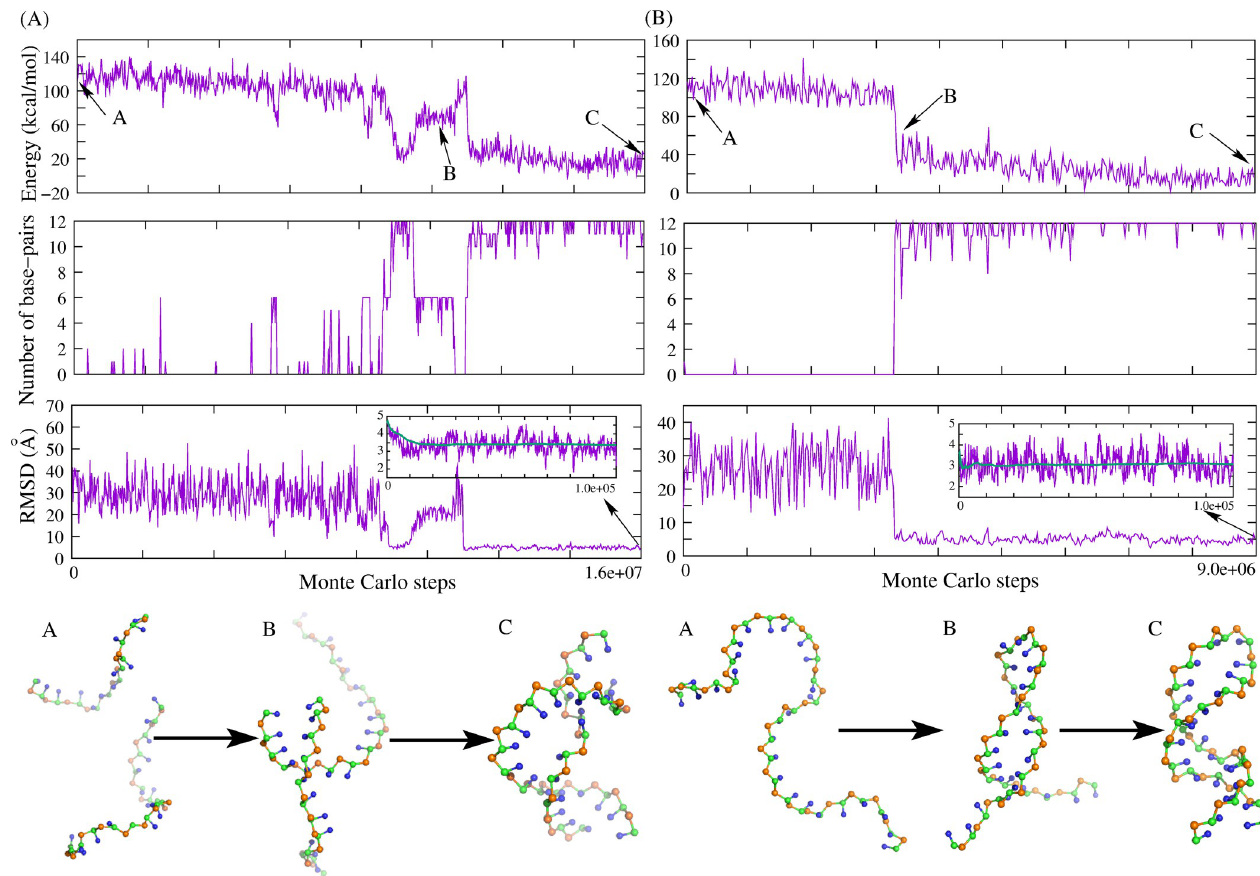
Fig 2. 3D structure prediction for the paradigm dsDNA/ssDNA in the present model. (A,B) The time-evolution of system energy, number of base-pairs, RMSD from native structure, and typical 3D conformations (from top to bottom, respectively) during the Monte Carlo simulated annealing simulation for (A) a dsDNA (PDB: 1qsk) and (B) an ssDNA (PDB: 1jve). The insets show the RMSDs of refined conformations calculated over all CG beads from the corresponding atoms in native structures. The 3D structures are shown with PyMol (http://www.pymol.org).